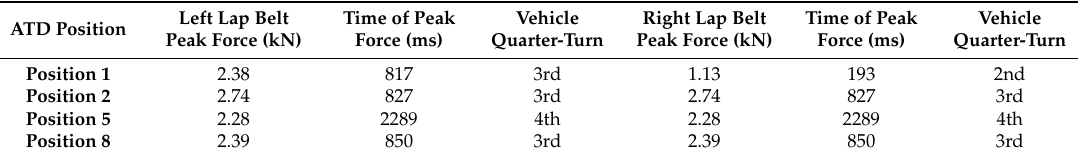
Table 13. Peak lap belt axial forces.